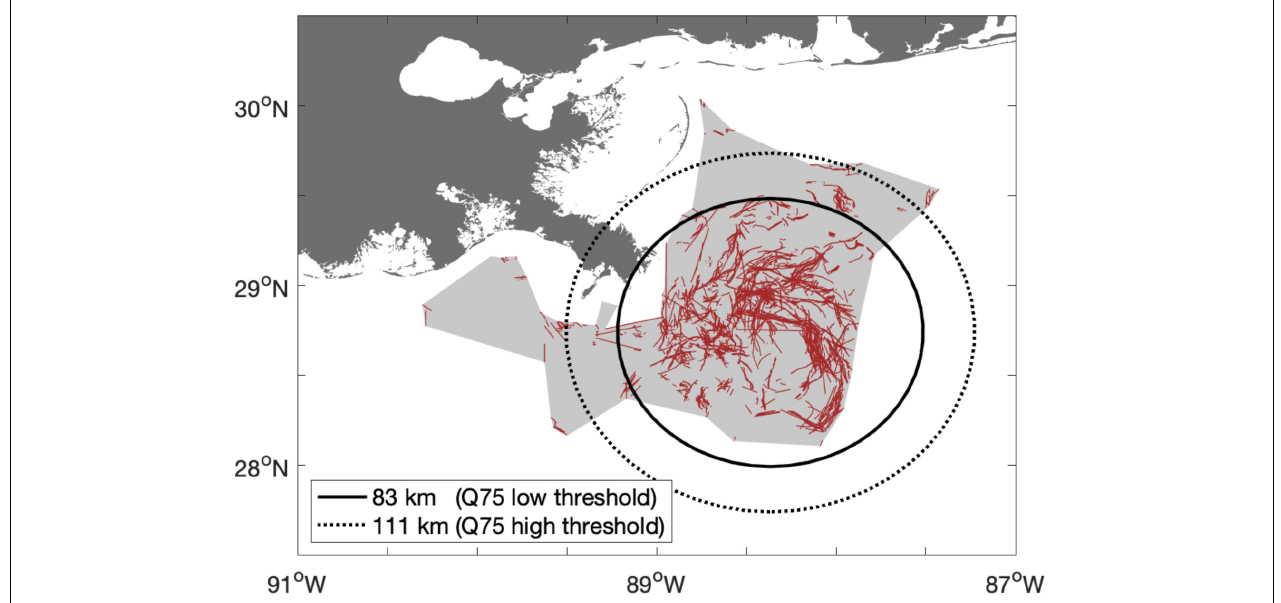
FIGURE 4 | Surface dispersant application (red tracks) and their envelope (gray polygon) during the Deepwater Horizon oil spill. Dashed and solid circles represent areas containing Q75 percentile of POCs formation, at a radial distance of 83 km and 111 km for the low and high thresholds, respectively; 93.9% and 99.3% of surface dispersant applications (total ca. 973,000 Gallons) occurred in the region where 75% of POC formation occurred, for the lower solar irradiance threshold (1.16*10 7 J m − 2 ) and higher irradiance threshold (6.60*10 7 J m − 2 , Ward et al., 2018a),